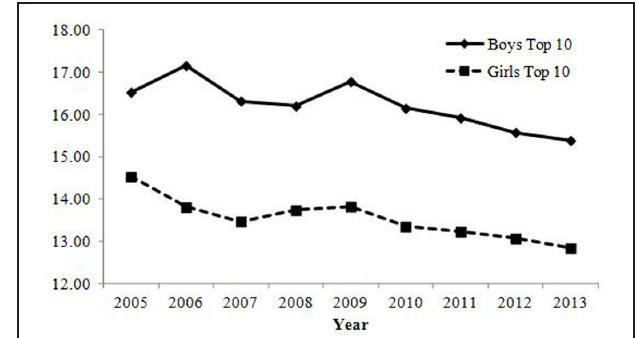
FIGURE 2 | Percentage of babies receiving names with one of the top 10 most common Chinese characters (individual character) in Study 1. The rate of babies with common Chinese characters has increased and changes were sufficiently large in magnitude.